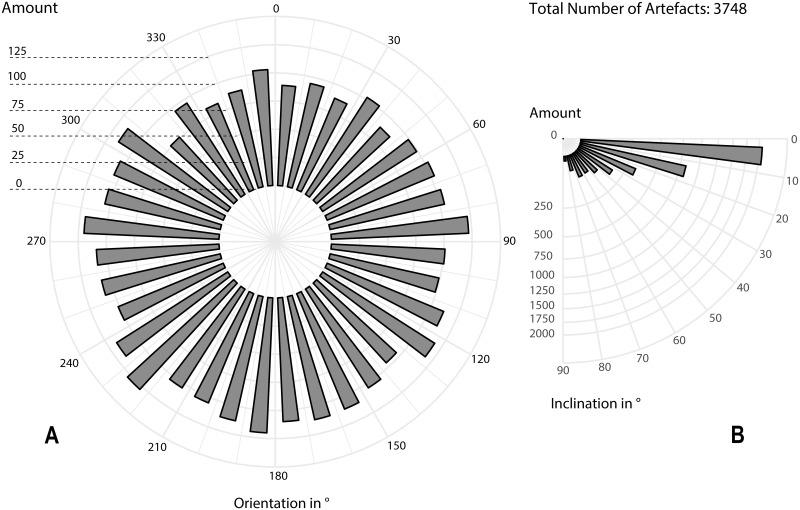
Orientation (A) and inclination (B) of elongated lithic artefacts.Each bar shows the absolute number of artefacts within the given orientation and distance-class (by 10° steps). The diagram shows all elongated lithic artefacts that were measured with two points during excavation (Total n = 3748; software: ggplot).